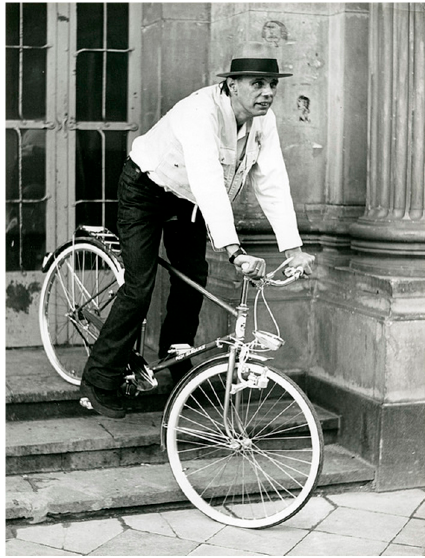
Figure 3. Joseph Beuys photographed by Hans Lachmann at the Kunstakademie in Düsseldorf [56].